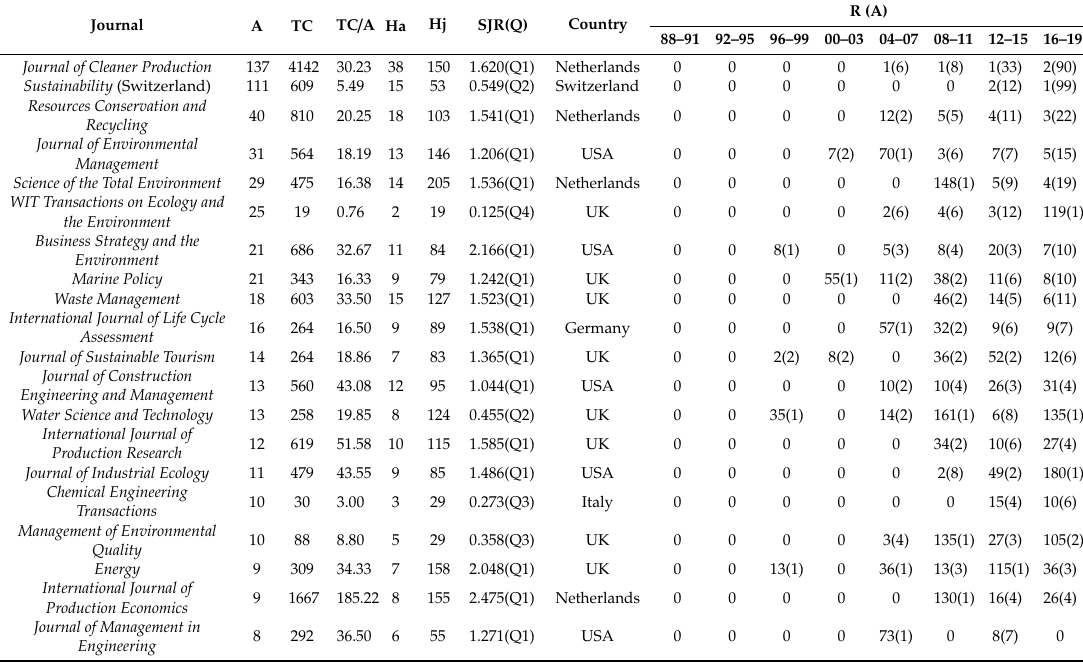
Table 3. Top 20 prolific journals